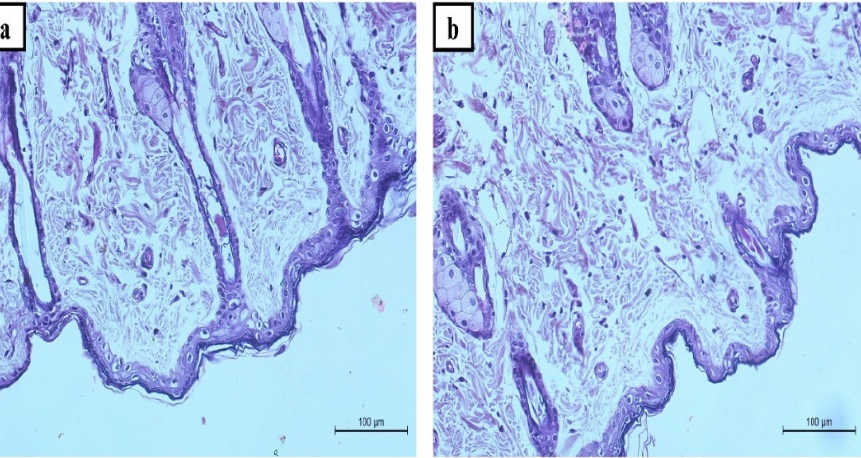
Figure 7. Representative histopathological images of untreated rat skin group ( a ) and BER-CTS-BLS gel treated rat skin group ( b ).